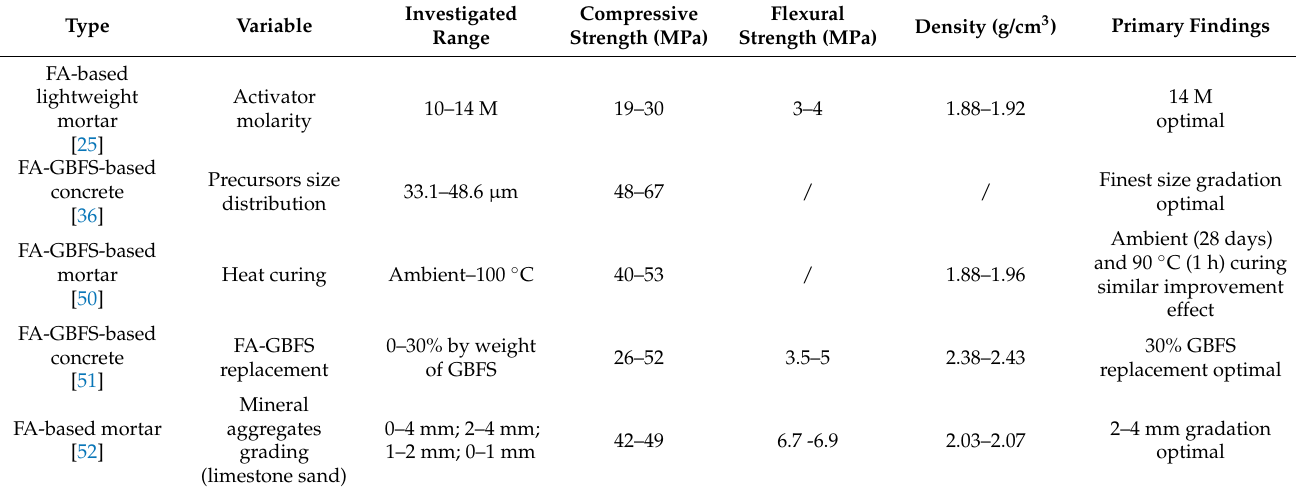
Table 3. Effect of process variables on the mechanical properties of geopolymer